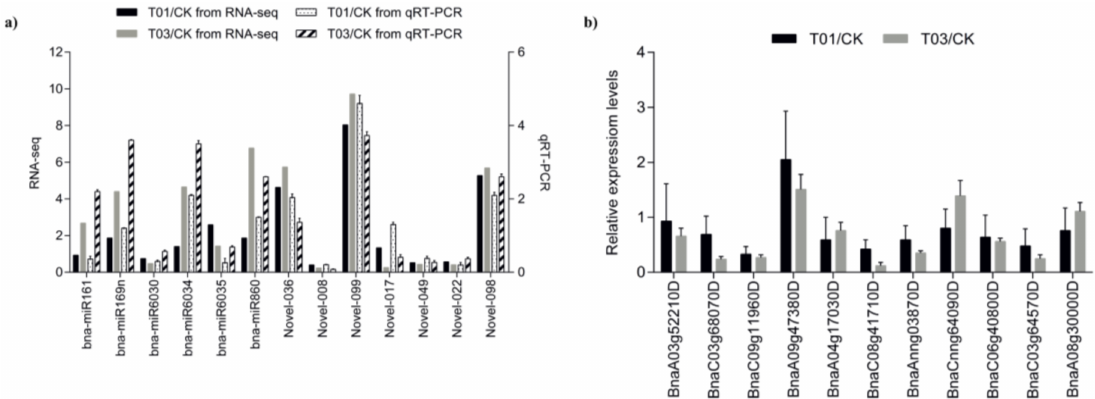
Figure 5. Validation and comparison of the expression of 13 miRNAs between qRT–PCR and small RNA sequencing ( a ) and 11 corresponding target genes ( b ). Fold change of miRNA expression relative to the control sample.